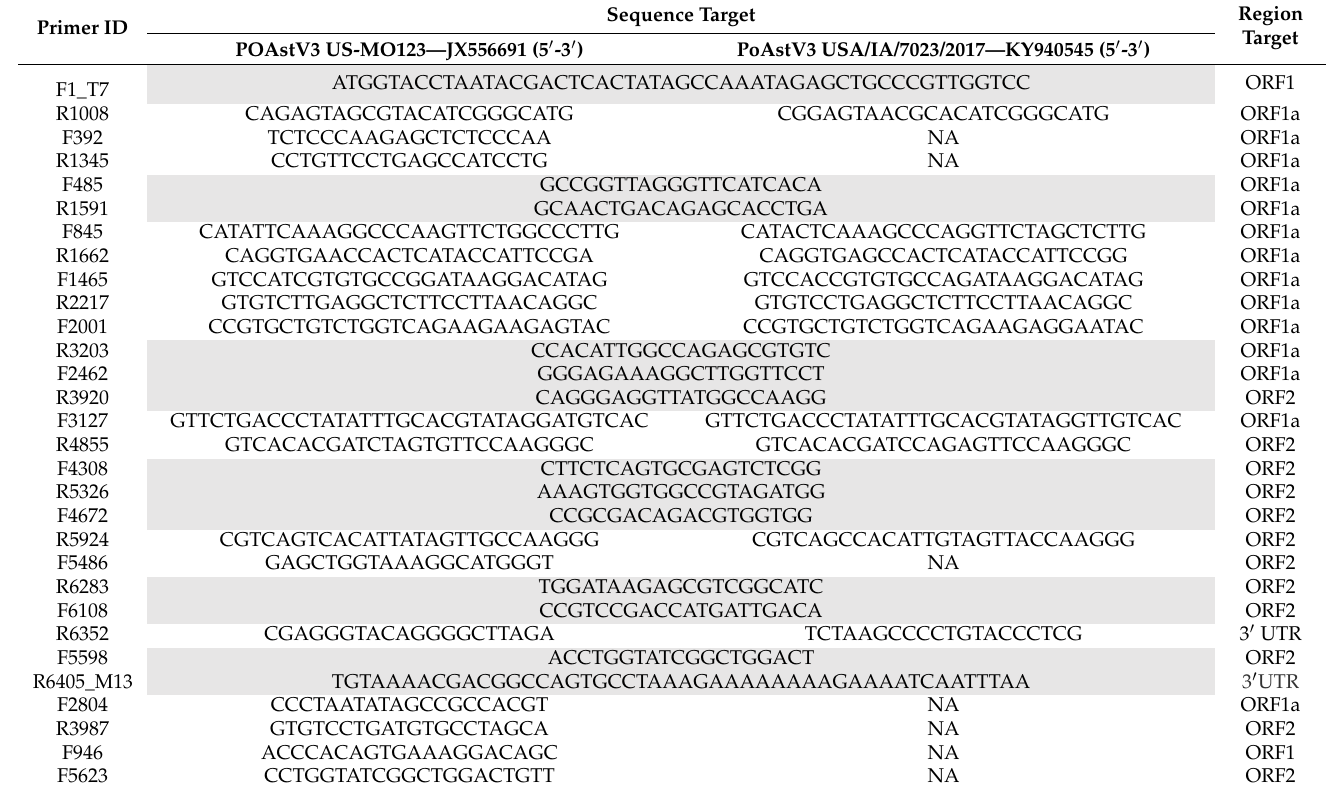
Table 1. List of forward and reverse primers used for sequencing of